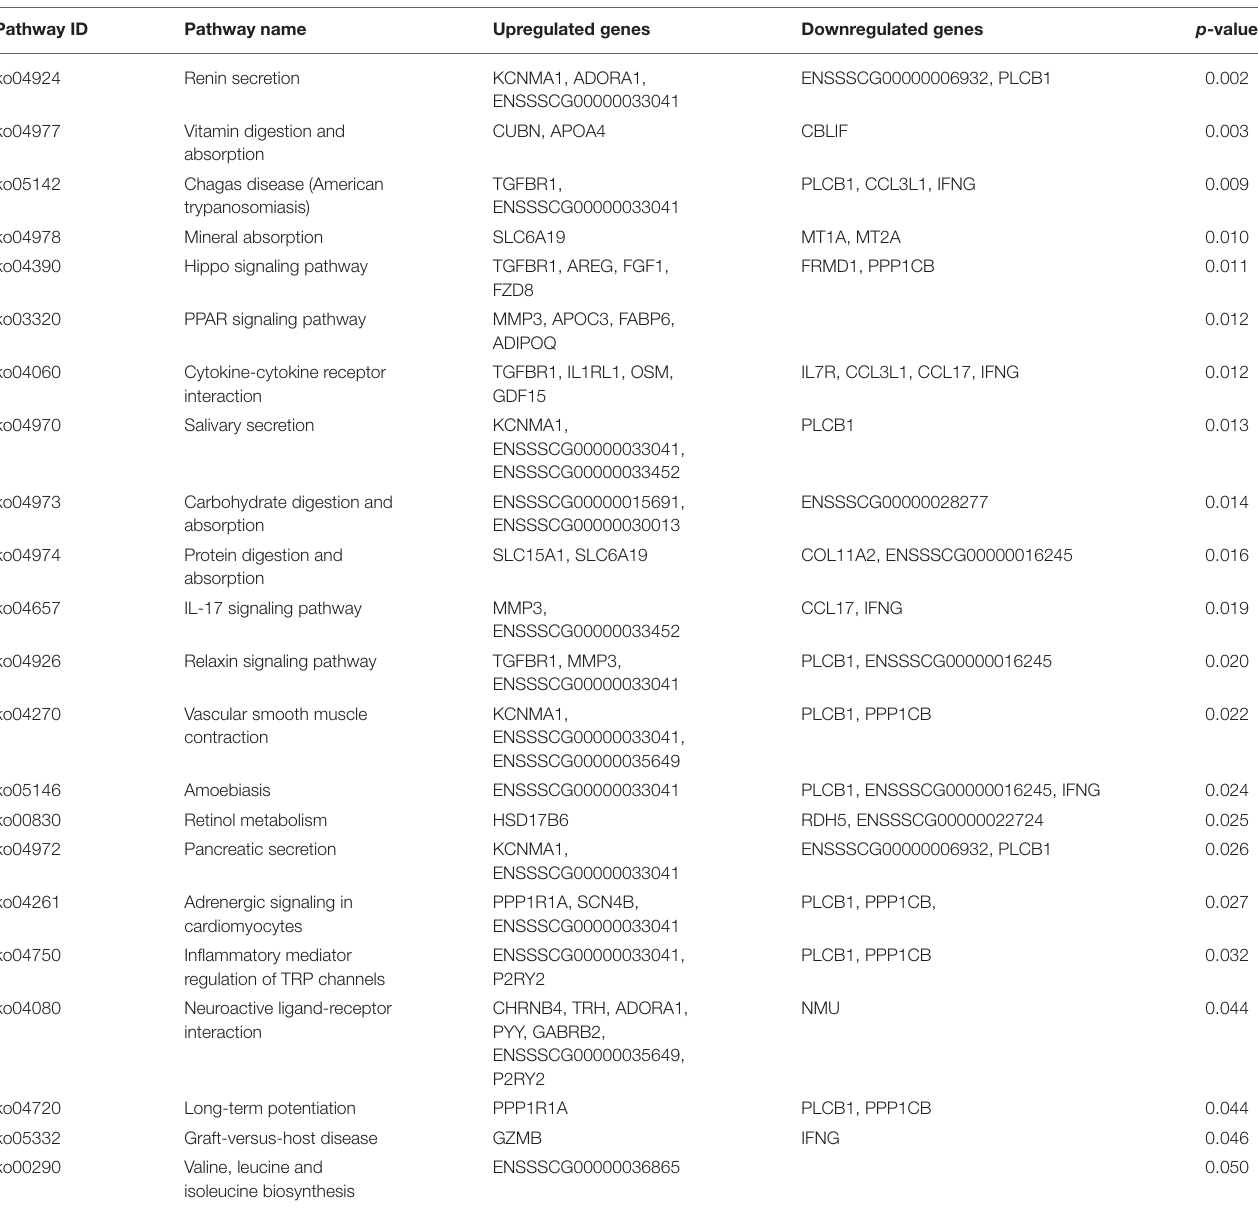
TABLE 3 | KEGG pathway enrichment of DEGs (ISC vs. CON). Pathway